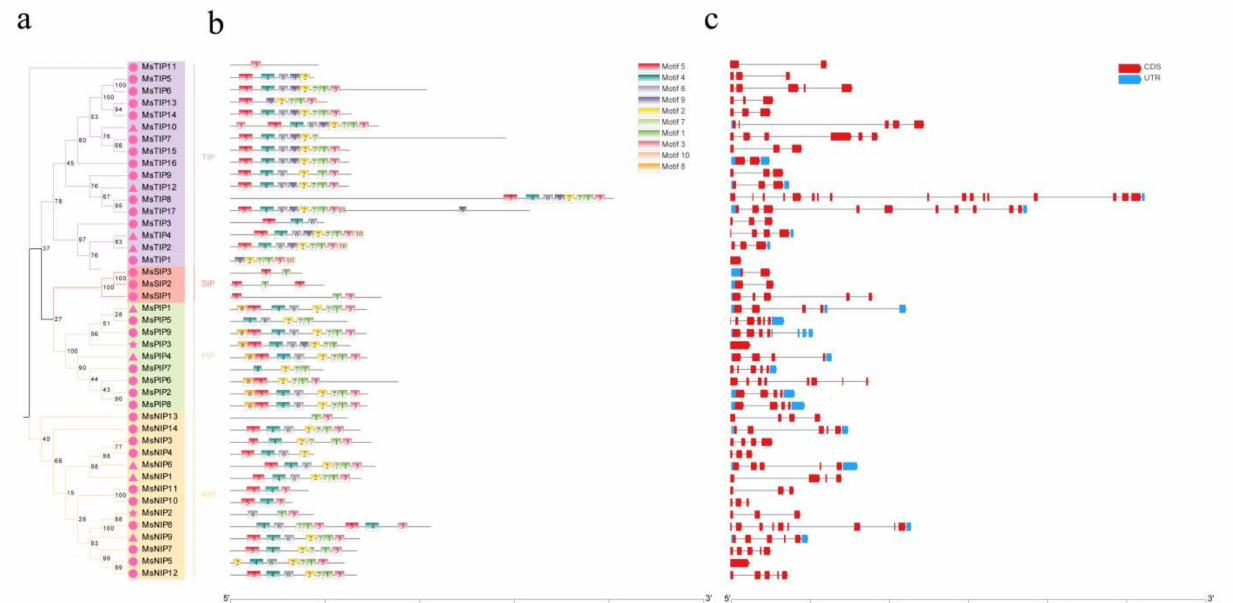
Figure 3. Analyses of the phylogenetic relationships, motifs and gene structure of AQP genes from M. sativa . Phylogenetic relationships ( a ); location of motifs ( b ); and gene structure of MsAQP genes ( c ). In ( c ), blue boxes indicate 5 (cid:48) - or 3 (cid:48) - untranslated regions, red boxes indicate exons, and black lines indicate